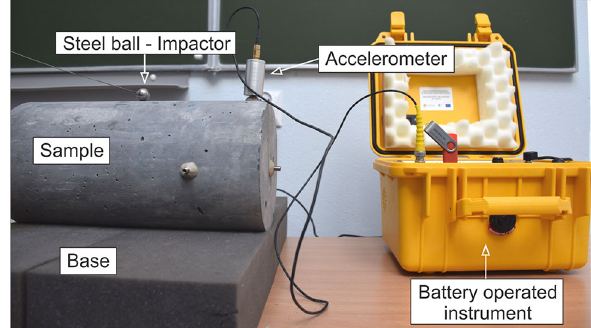
Fig. 3 Set-up of dynamic modulus of elasticity test for cylindrical